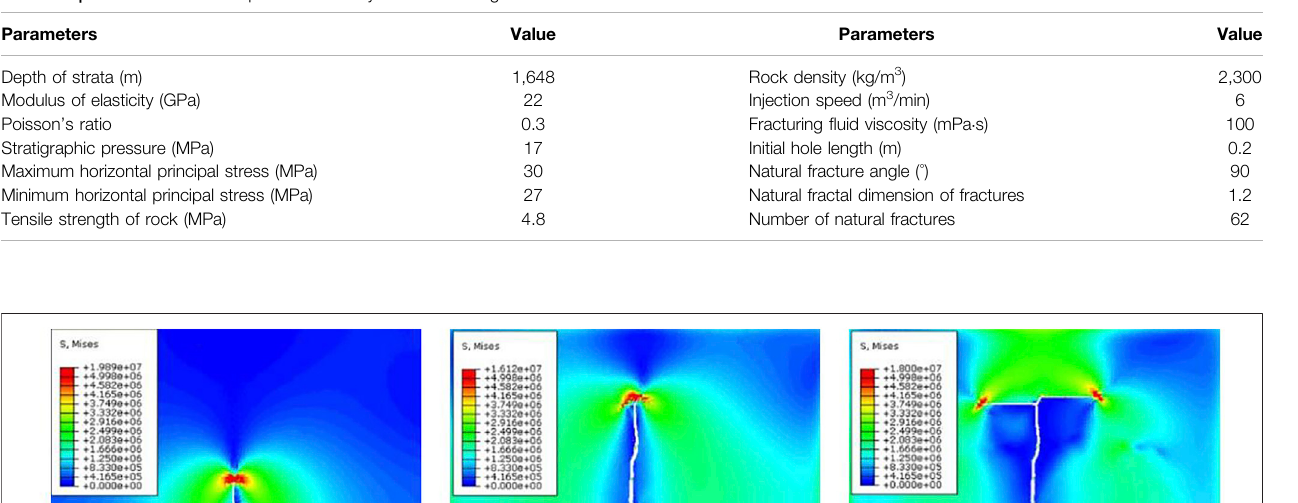
TABLE 1 | Numerical simulation parameters of hydraulic fracturing in multi-fractured reservoirs.